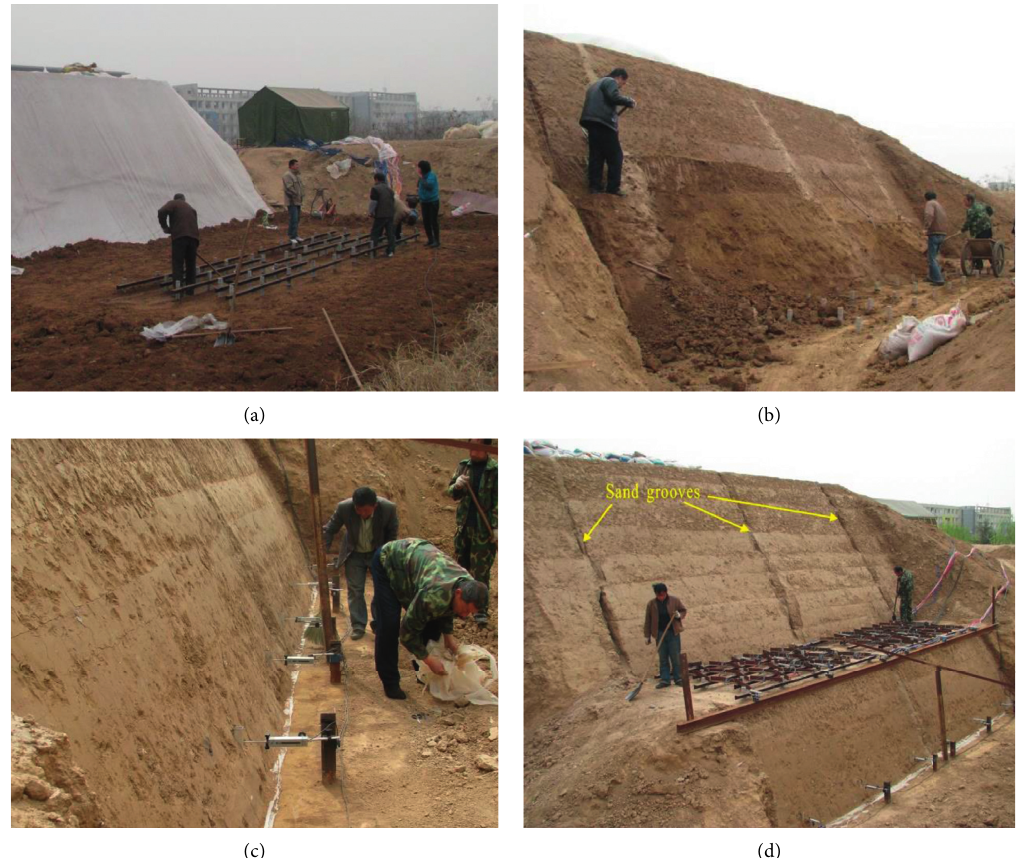
Figure 2: The manufacturing process of the sliding body. (a) Layered filling of soil; (b) removing excess soil; (c) excavating the landslide toe; (d) the completed test model.